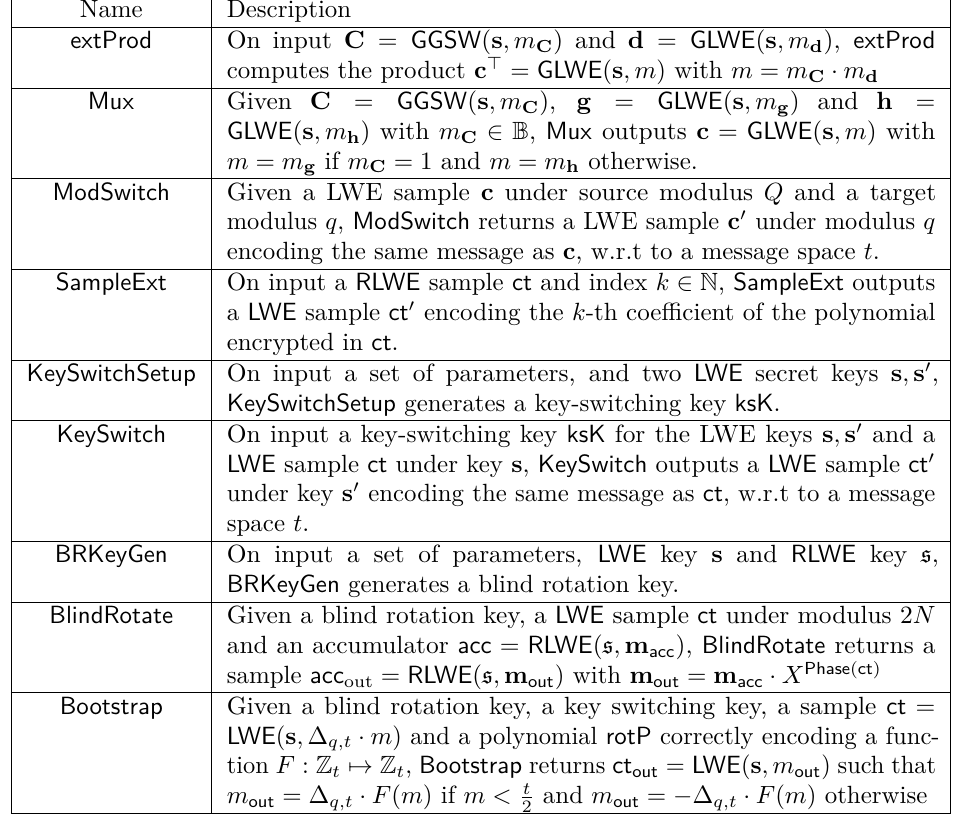
Table 1: List of procedures. The table contains an informal summary of the procedures from Section